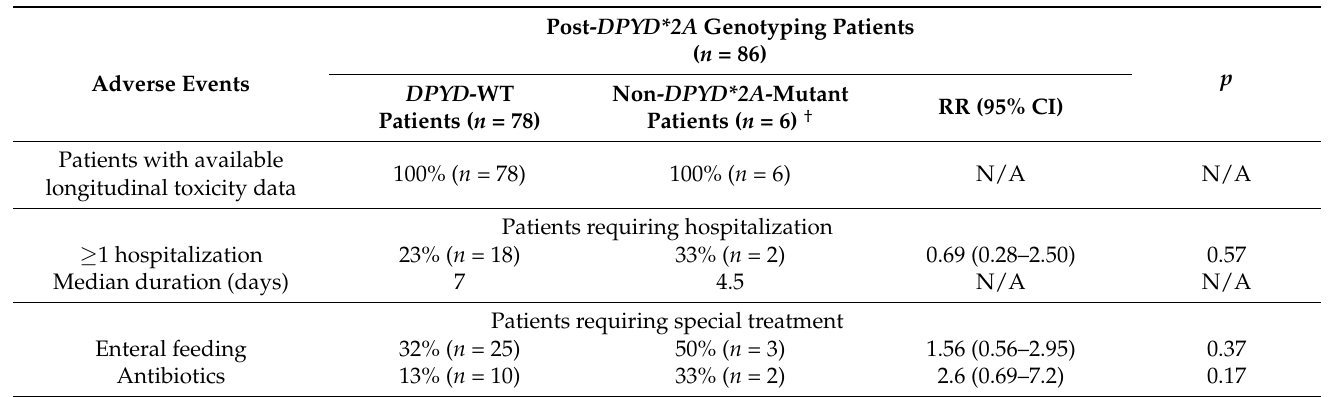
Table 4. Medical interventions indicated for previously reported